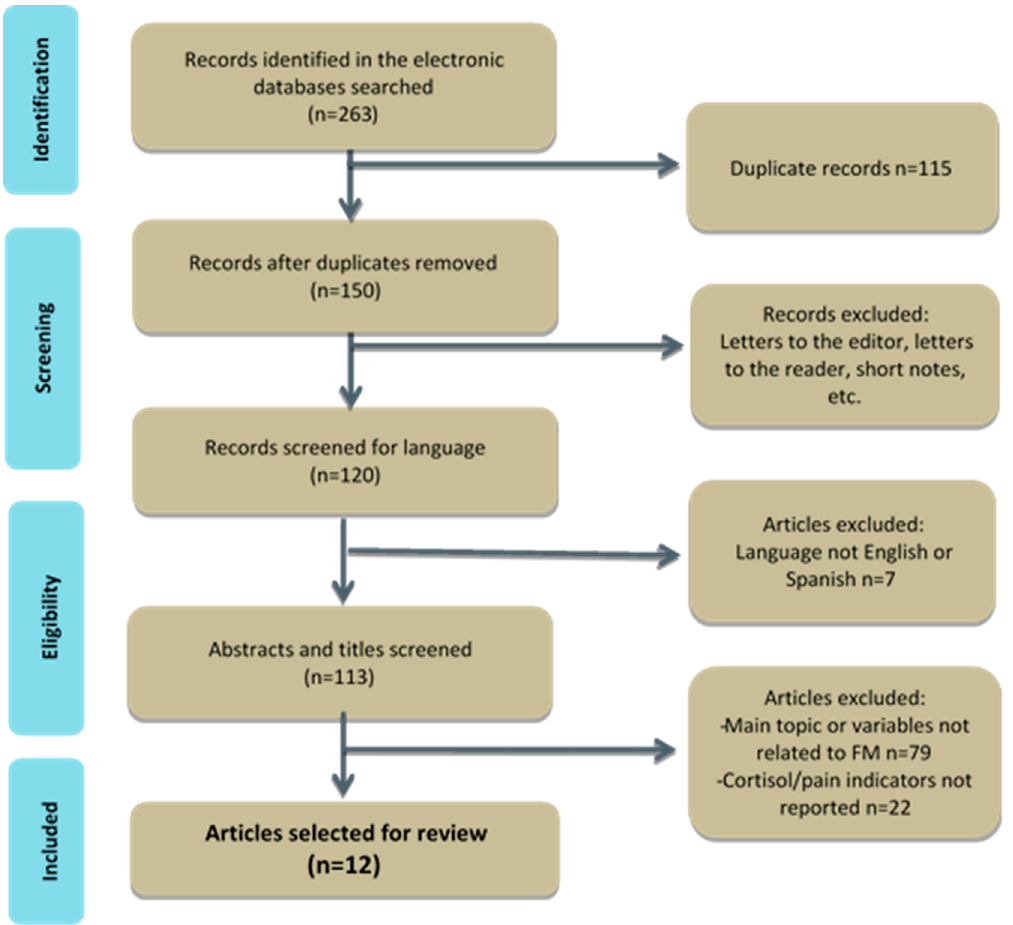
Figure 1. Articles identified for this review. FM=Fibromyalgia.